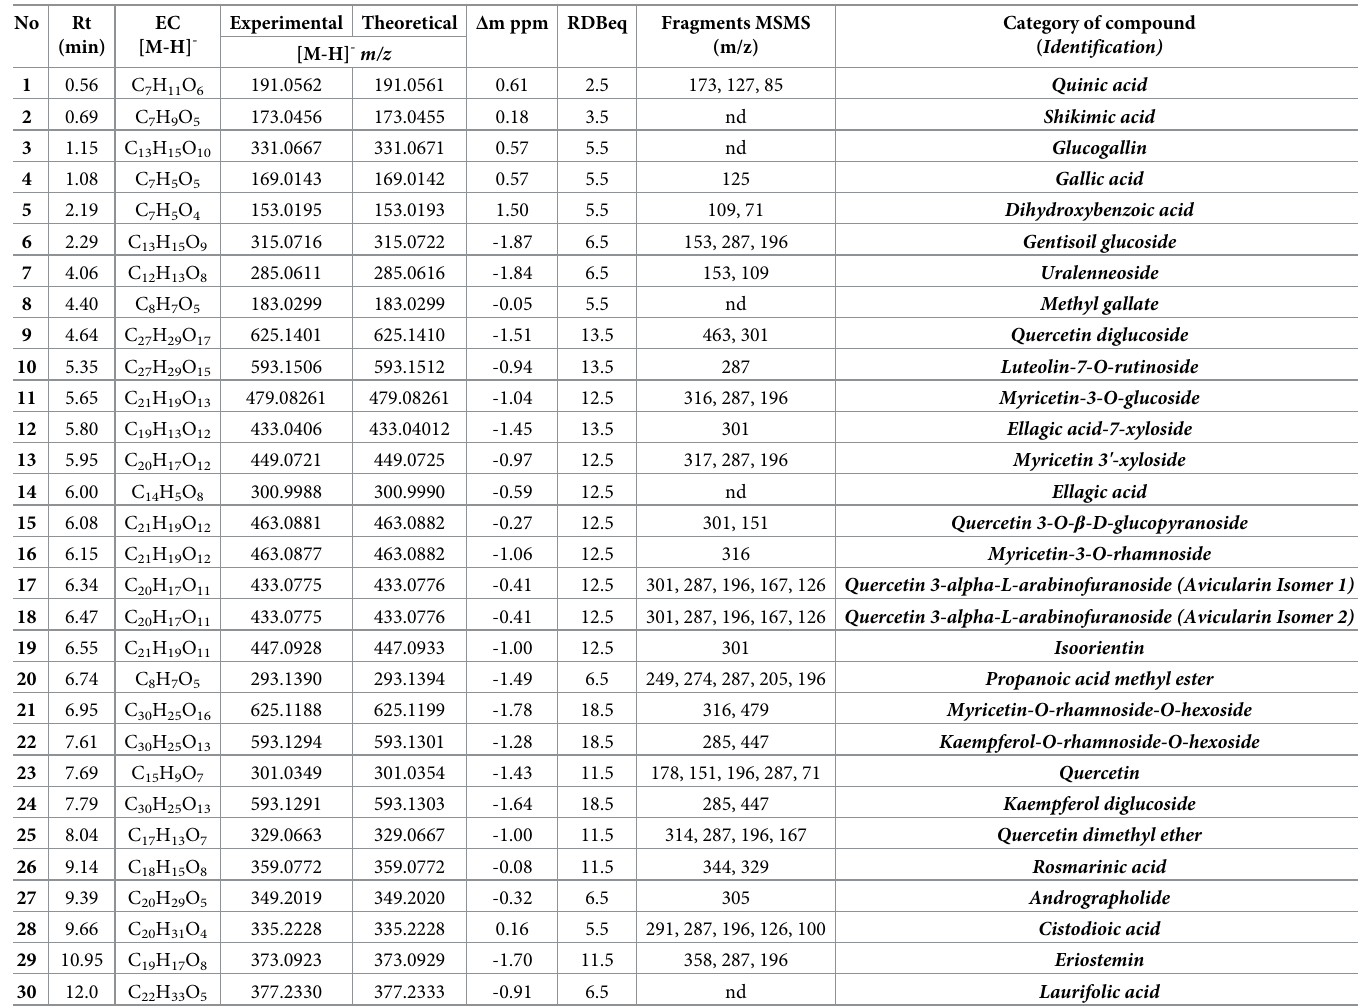
Table 6. LC(ESI-)HRMS of C . monspeliensis methanol